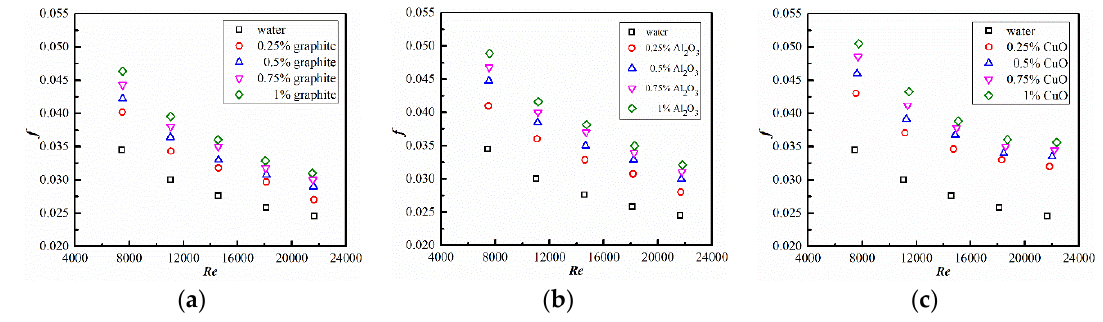
Figure 3. Variations of f with Re : ( a ) graphite; ( b ) A1 2 O 3 ; ( c ) CuO.